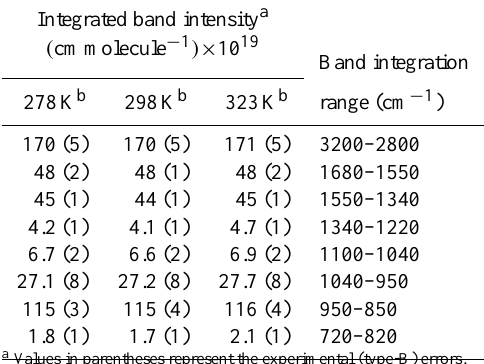
Figure 5. Quantitative infrared spectrum of isoprene from 840 to 1100cm − 1 recorded at 298K. Absorption cross sections are given in Naperian units (cm 2 molecule − 1 ) × 10 19 for the composite spec- trum recorded at 298K.